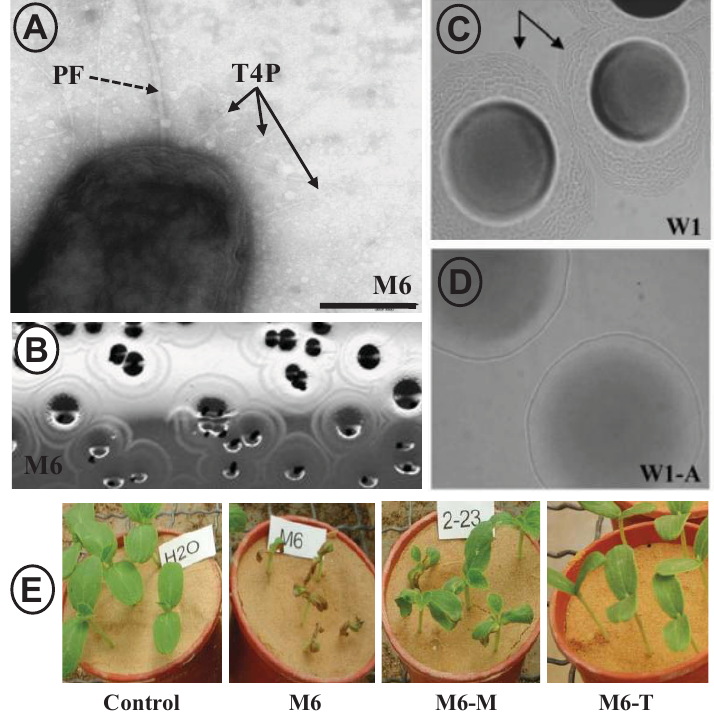
Figure 4. T4P in Acidovorax citrulli , causal agent of bacterial fruit blotch and seedling blight of cucurbit plants. ( A ) Transmission electron microscopy of wild-type strain M6 following growth for 48 h on nutrient agar (NA) plates. Solid and dashed arrows indicate T4P and polar flagellum (PF), respectively (bar = 0.5 μm) ; ( B ) Typical twitching halos surrounding bulk colonies of strain M6 after 96 h of growth on NA; seen by the naked eye; ( C ) Twitching halos seen around colonies of strain W1 by light microscopy after 96 h of growth on NA; ( D ) Halos are not detected around colonies of a W1 pilA mutant (strain W1-A; lacking T4P and twitching motility) grown under similar conditions as described for W1 in C; ( E ) Effects of T4P deficiency on virulence of A. citrulli , assessed by seed-transmission assays with melon cv. Ophir. Seeds were incubated with the different strains (at 10 6 cfu/mL), and sowed in pots containing sand that were kept in a greenhouse at 25 – 28 °C. Pictures were taken 8 days after sowing. M6, wild type; M6-M, pilM mutant; M6-T, pilT mutant; control, seedlings from non-inoculated seeds. Figure composed from figures published by Bahar and colleagues